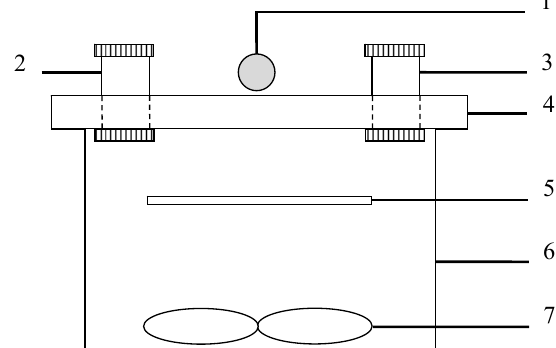
Figure 1. Experimental facility for photocatalytic degradation of HCHO: ( 1 ) light source (a 500 W xenon lamp), ( 2 ) humidity controller, ( 3 ) sampling/injection port, ( 4 ) quartz cover, ( 5 ) glass plate with photocatalyst, ( 6 ) stainless steel container, ( 7 ) electric fans.